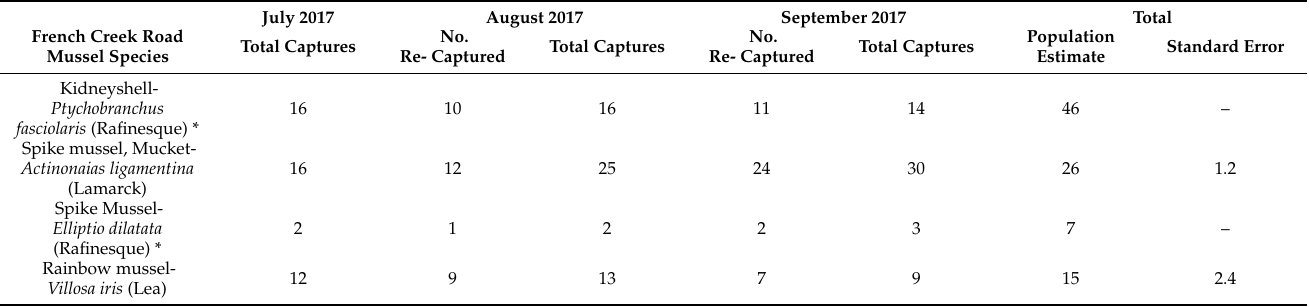
Table 2. Population estimates for the four most common species of mussels at the French Creek Road sampling site. Species denoted by an asterisk are populations whose population estimate was less than the sample size. For these species, the true number of individuals observed is